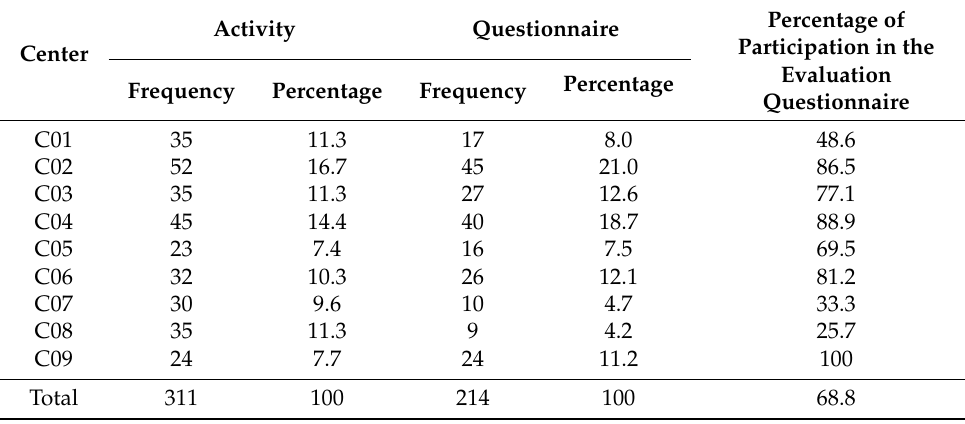
Participation in the Evaluation